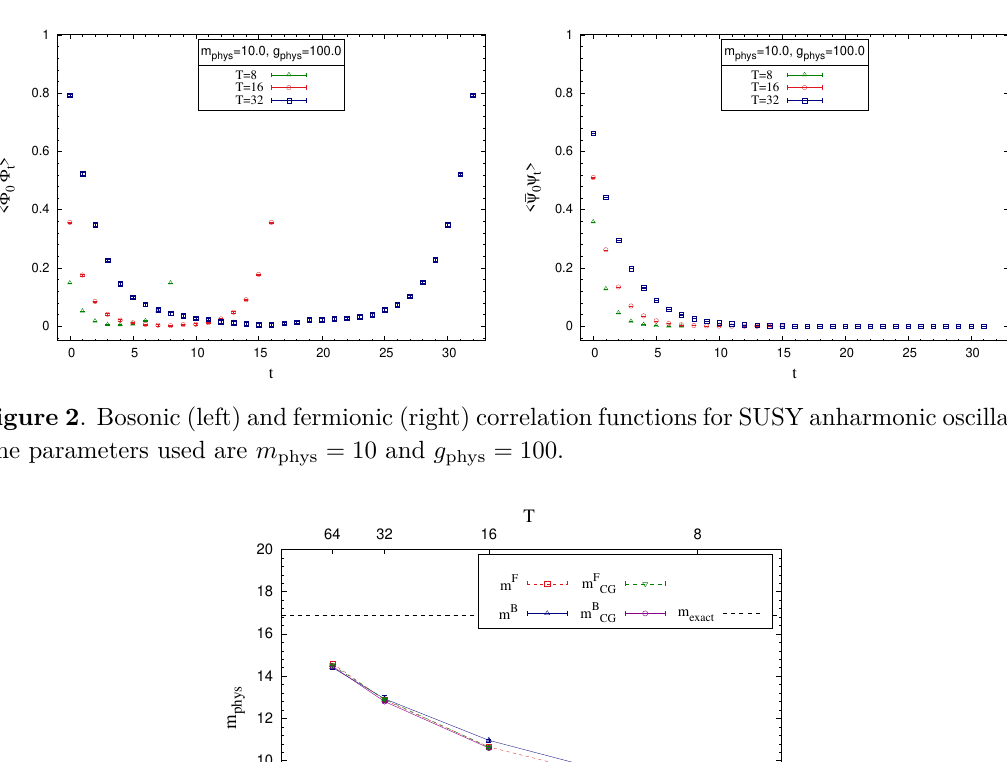
Table 2 . Expectation value of the auxiliary field B α and the bosonic action S B monic oscillator. The parameters used are m phys = 10 and g phys = 100 .